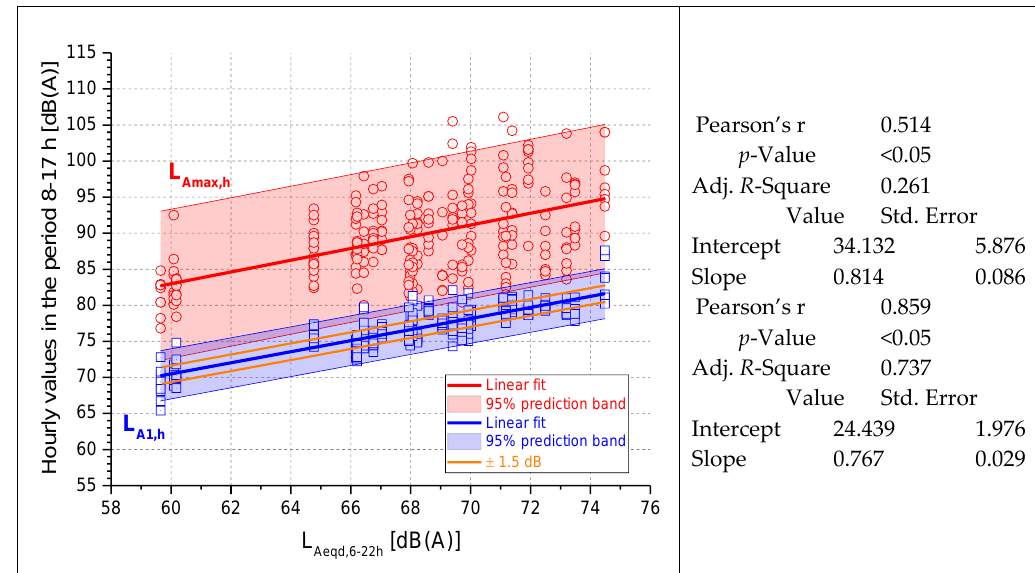
Figure 7. Linear regressions between hourly values in the interval 6 – 22 h of both L Amax and L A1 versus L Aeq, 6 – 22 h for all the streets.